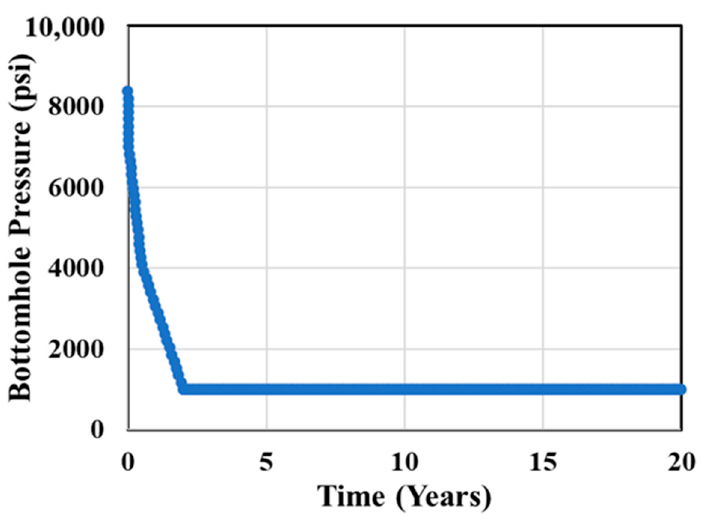
Figure 5. Flowing bottomhole pressure (BHP) used for each well as the reservoir simulation constraint.